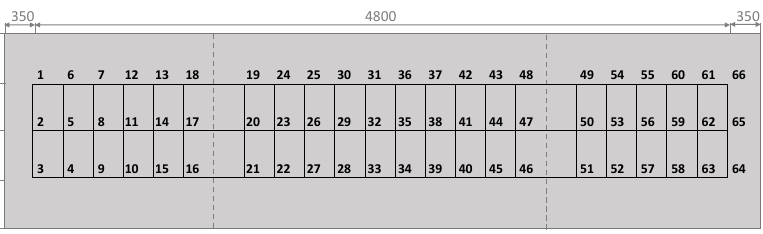
Figure 4. Excited point distribution on steel deck (red arrows). Blue arrow indicates sensor location.